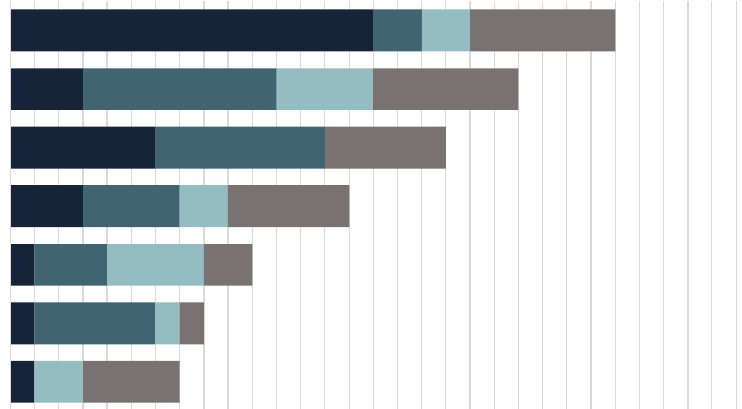
Figure 4. The main environmental hazards, exposures, and/or conditions included in integrated surveillance systems designed or recommended for Circumpolar Arctic and Subarctic regions, stratified by discipline (i.e., the first author’s primary discipline), as reported in the literature. The first author’s primary discipline was identified via the department they were affiliated with when the article was published. Affiliations were typically listed on the first page of each article, and any affiliations that were not listed were obtained via internet searches. Categories are not mutually exclusive.